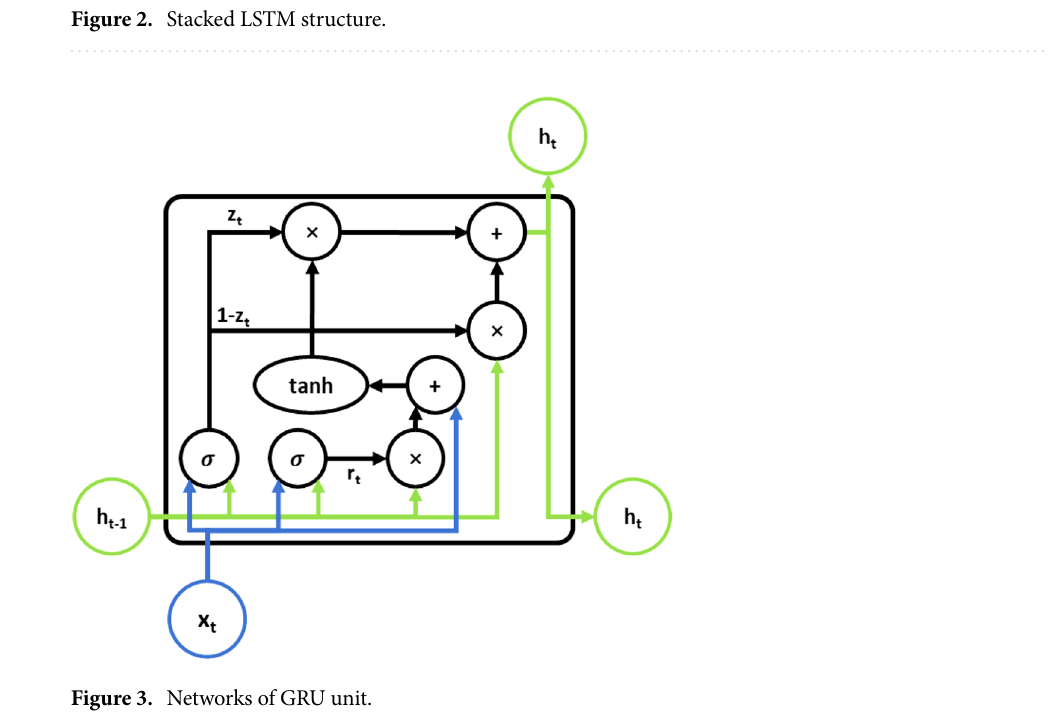
Figure 3. Networks of GRU